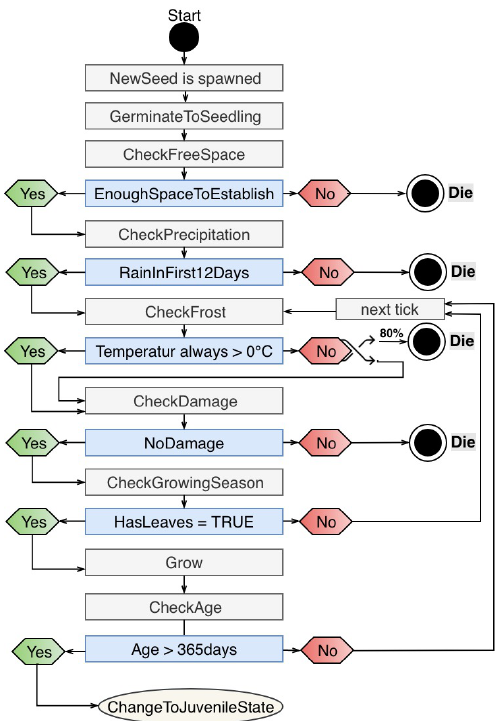
Figure A2. Daily tick routine for Tree agent in seedling state.